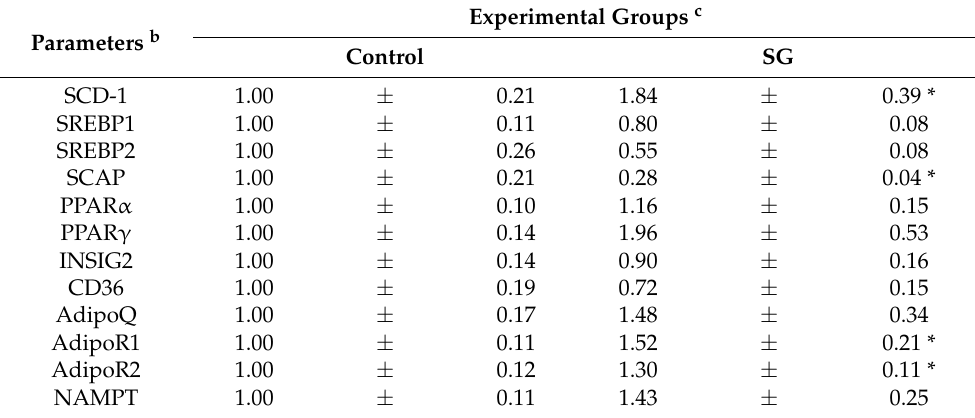
Table 2. Effect of the phytogenic water additive SG on lipid metabolism genes in liver tissue a .